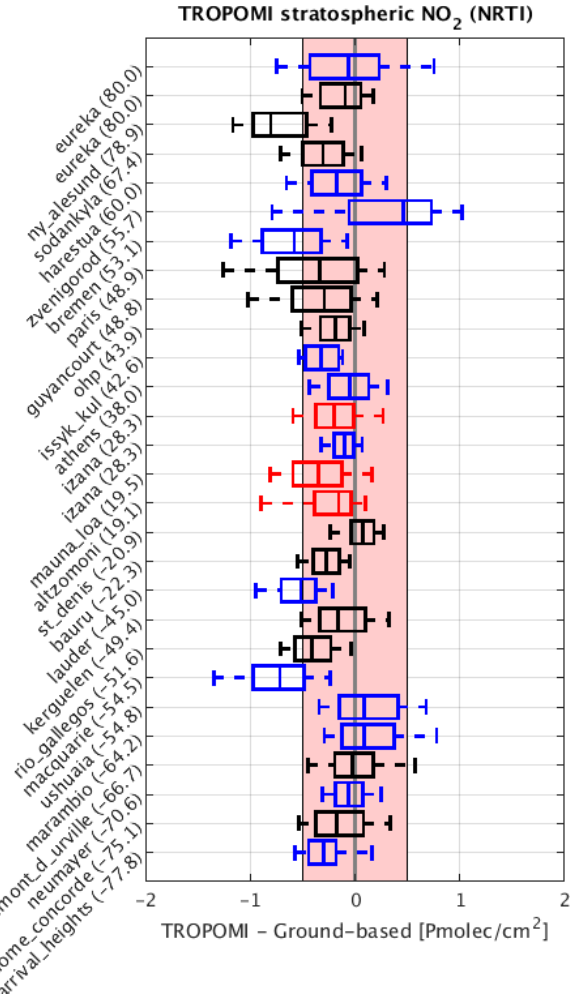
Figure 6. Box-and-whisker plots summarizing from pole to pole the bias and spread of the difference between S5P TROPOMI NRTI and NDACC ZSL-DOAS NO 2 stratospheric columns (SAOZ data in black, other ZSL-DOAS in blue, and PGN in red). The median difference is represented by a vertical solid line inside the box, which marks the 25% and 75% quantiles. The whiskers cover the 9%–91% range of the differences. The shaded area represents the mission requirement of 0.5Pmoleccm − 2 for the uncertainty. Values between brackets in the labels denote the latitude of the station.